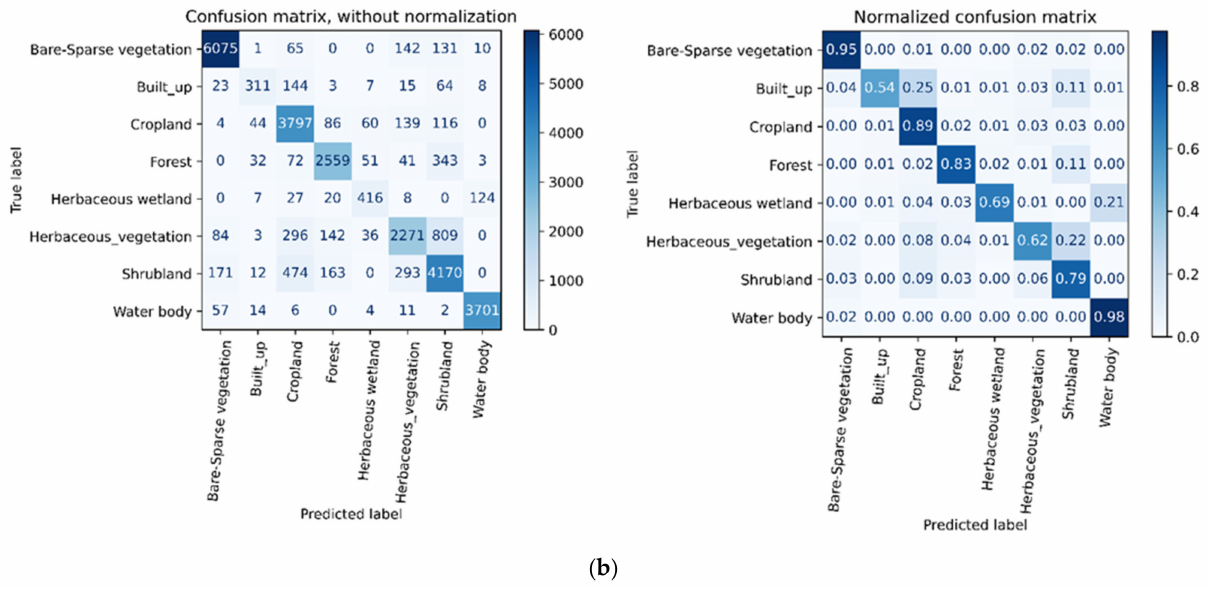
Figure 5. Confusion matrices of the best model of each classifier: ( a ) confusion matrices of the best RF model; ( b ) confusion matrices of the best SVM